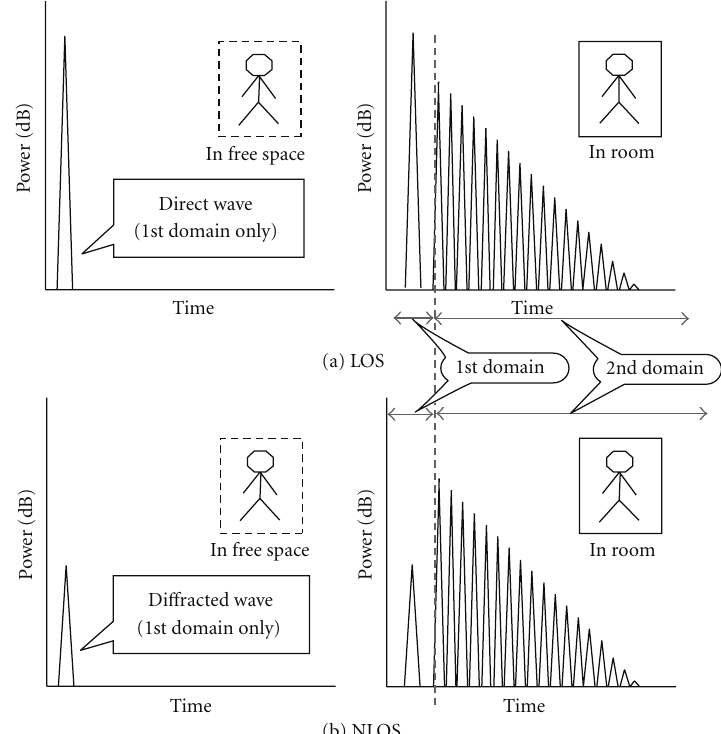
Figure 4: Conceptual diagram of the division of the delay profiles: (a) LOS and (b) NLOS. The first domain represents the delay profiles measured in free space or radio anechoic chambers and contains a direct or di ff racted wave along the body. The second domain consists of the remaining multipath components.